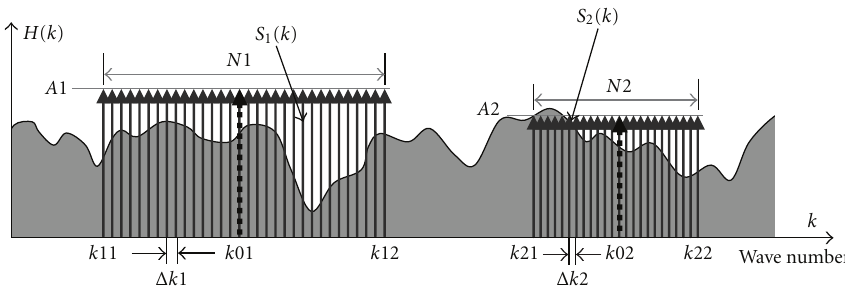
Figure 1: Spectrum of two swept sources, S 1 ( k ) and S 2 ( k ), with di ff erent parameters: central wavelength (k01, k02); impulse interval ( Δ k1, Δ k2 ); impulse intensity (A1, A2).